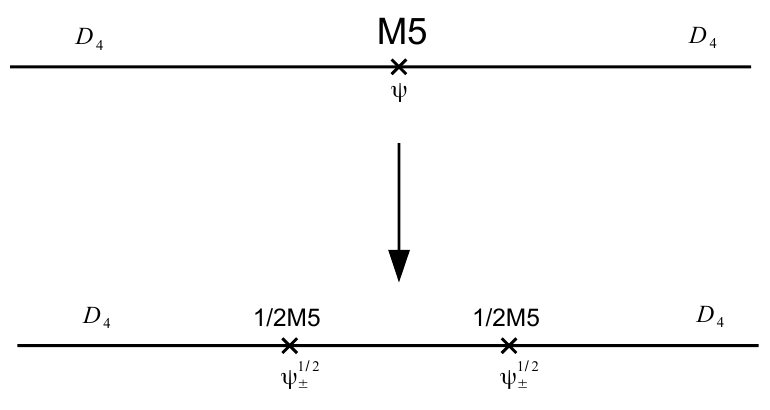
Figure 1 . M5 branes probing D-type